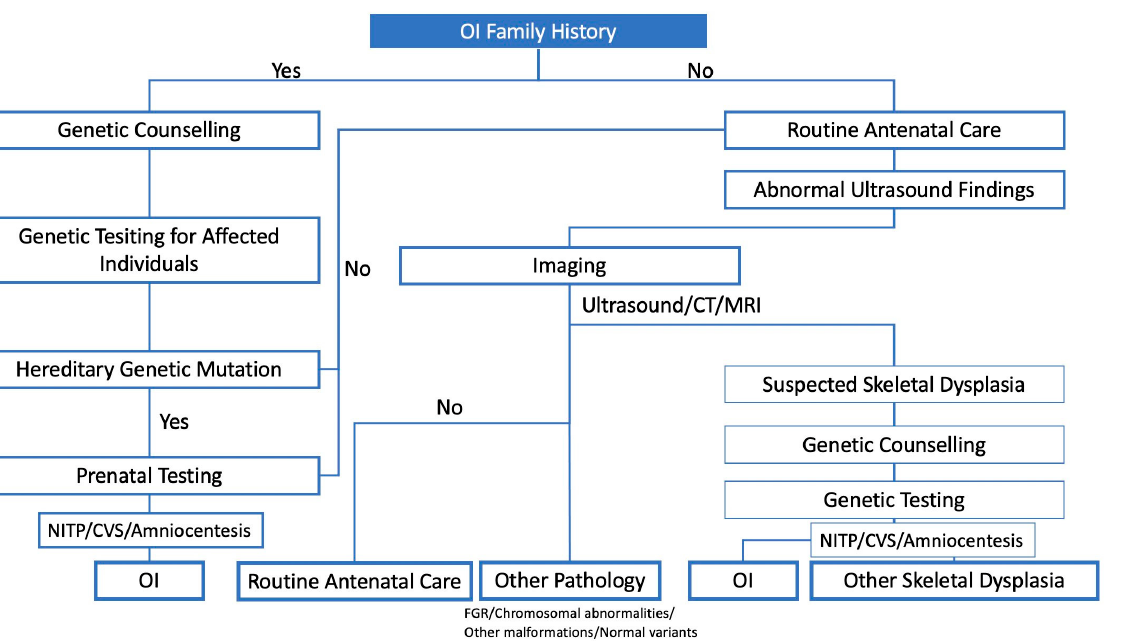
Table 1. Ultrasound parameters for foetal skeletal dysplasia.